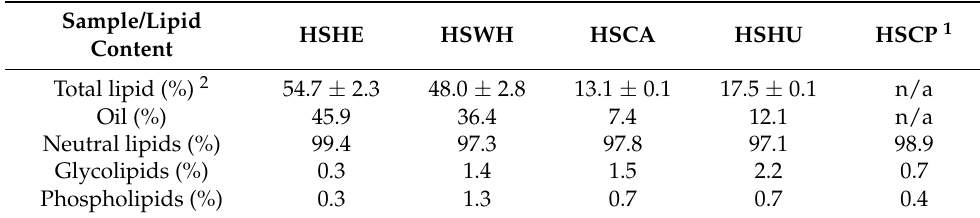
Table 1. Total lipid and oil extraction yield of hemp hearts (HSHE), hemp whole seeds (HSWH), hemp cake (HSCA) and hemp seed hulls (HSHU). Separation of lipid classes using solid phase extraction (SPE) expressed in percentage of oil.